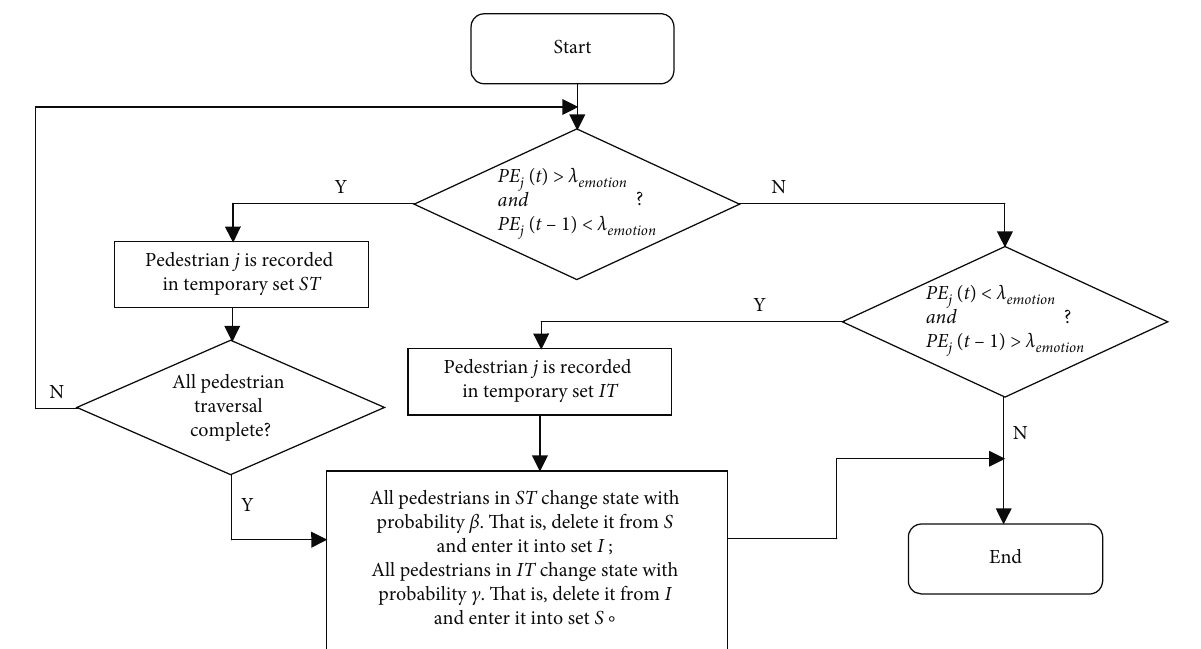
Figure 13: Update process of evacuation individual state in time t .